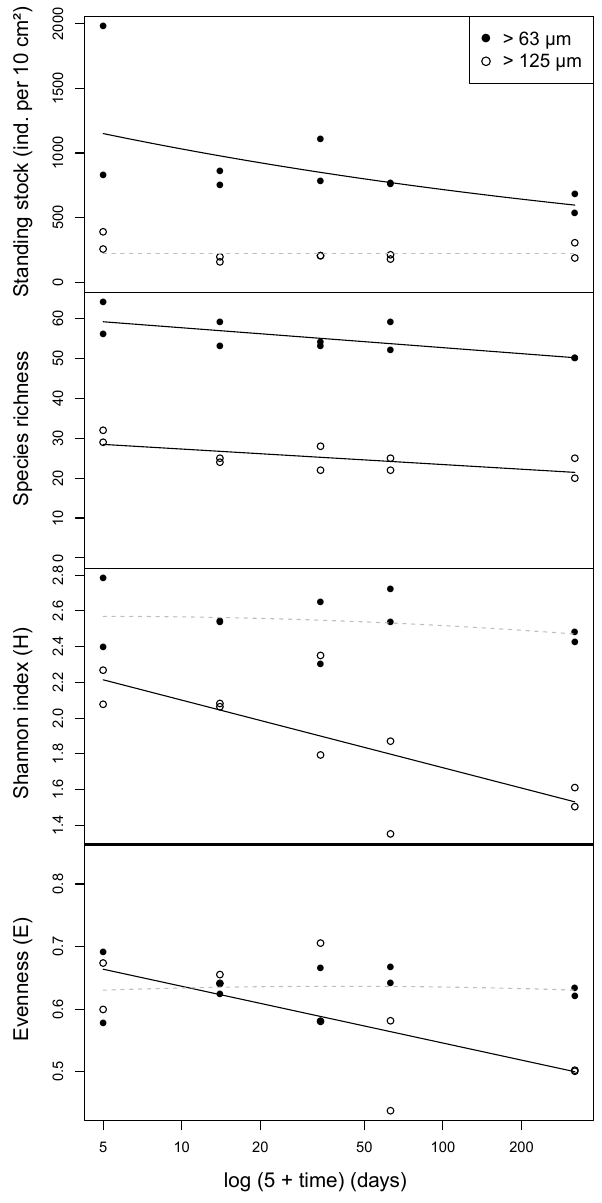
Fig. 1. Standing stock, species richness, Shannon index and even- ness variations with time in two size fractions (full circles: > 63µm; open circles: > 125µm). The lines are estimated after the model- type 1; full black line indicates that for the considered size the rela- tionship between the dependent variable and the independent vari- able is significant, while grey dashed lines indicate no significant